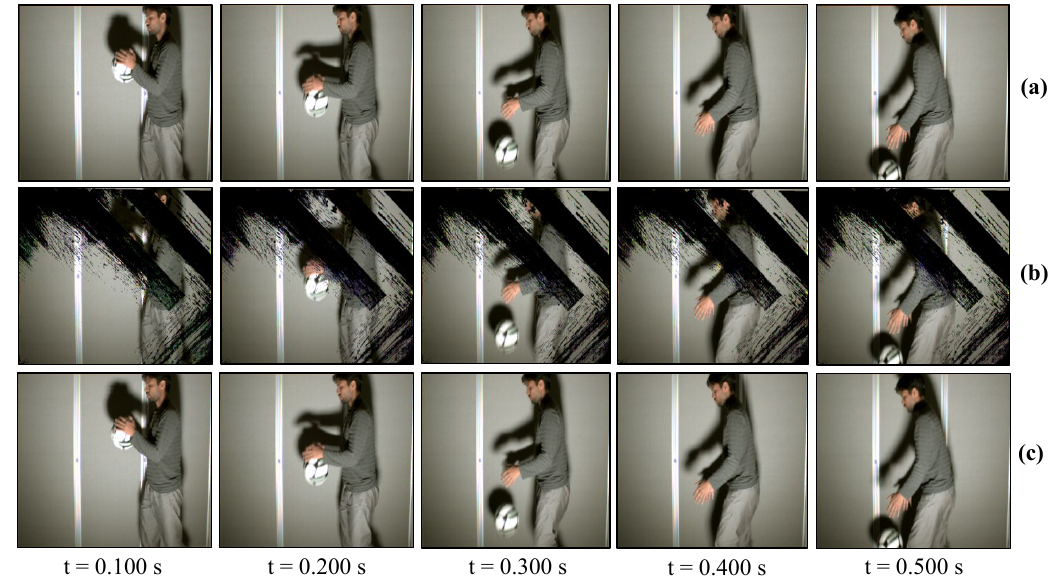
Figure 21. Reconstructed USB camera input image sequence on the pattern background: ( a ) 640 × 480 input image; ( b ) 510 × 459 binary-code image without background subtraction; and ( c ) 510 × 459 binary-code image with background subtraction.